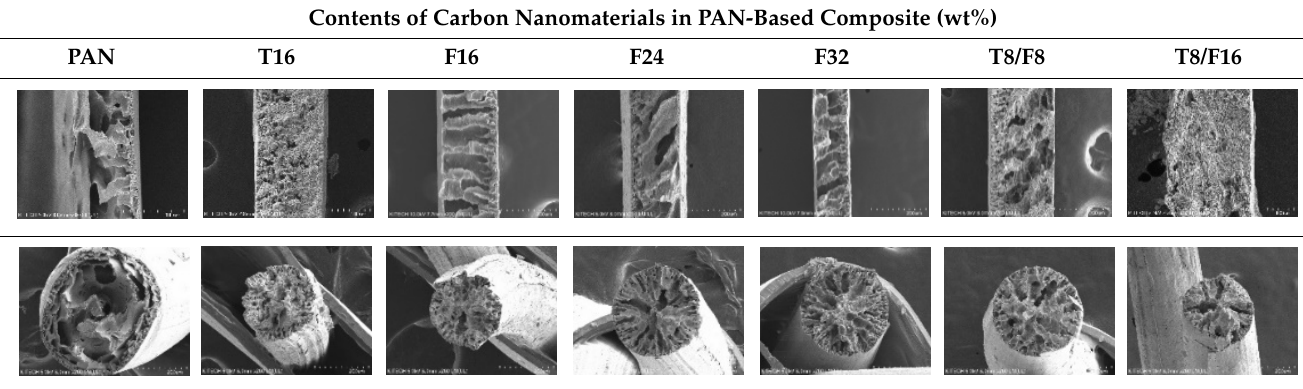
Table 5. Morphology of the PAN-based composite film and yarn with different contents of carbon nanomaterials (×200).